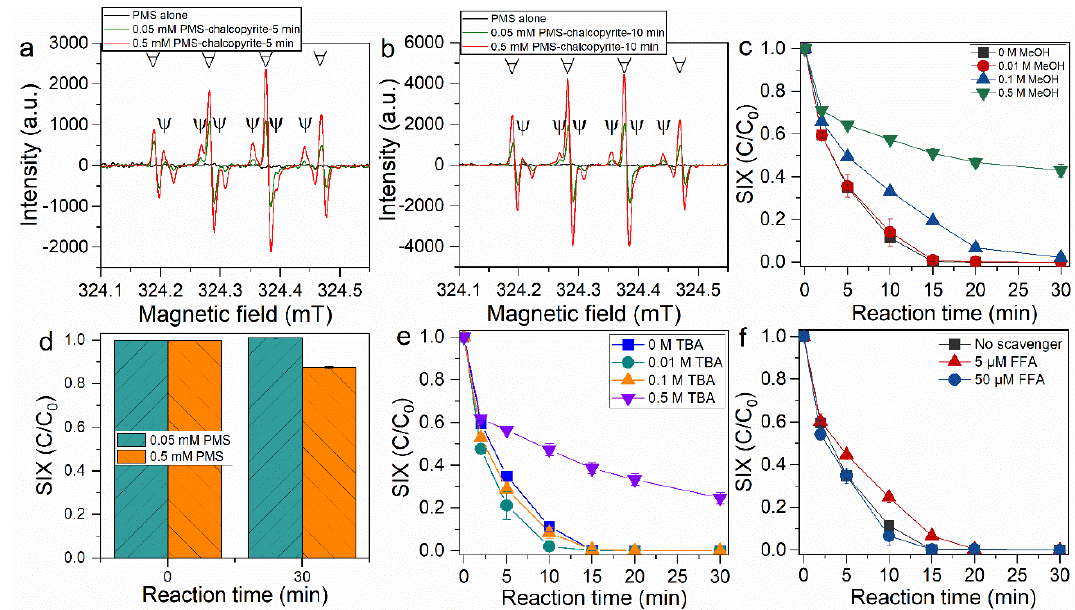
Figure 3. EPR spectra of chalcopyrite–PMS oxidation after reaction for ( a ) 5 and ( b ) 10 min; effects of ( c , d ) MeOH, ( e ) TBA, and ( f ) FFA on the degradation of SIX by chalcopyrite–PMS oxidation. Conditions: [SIX] = 5 mg/L, ( c – f ) [PMS] = 0.5 mM, [chalcopyrite] = 1 g/L, ( d ) [MeOH] = 5 M, and pH 3.0.